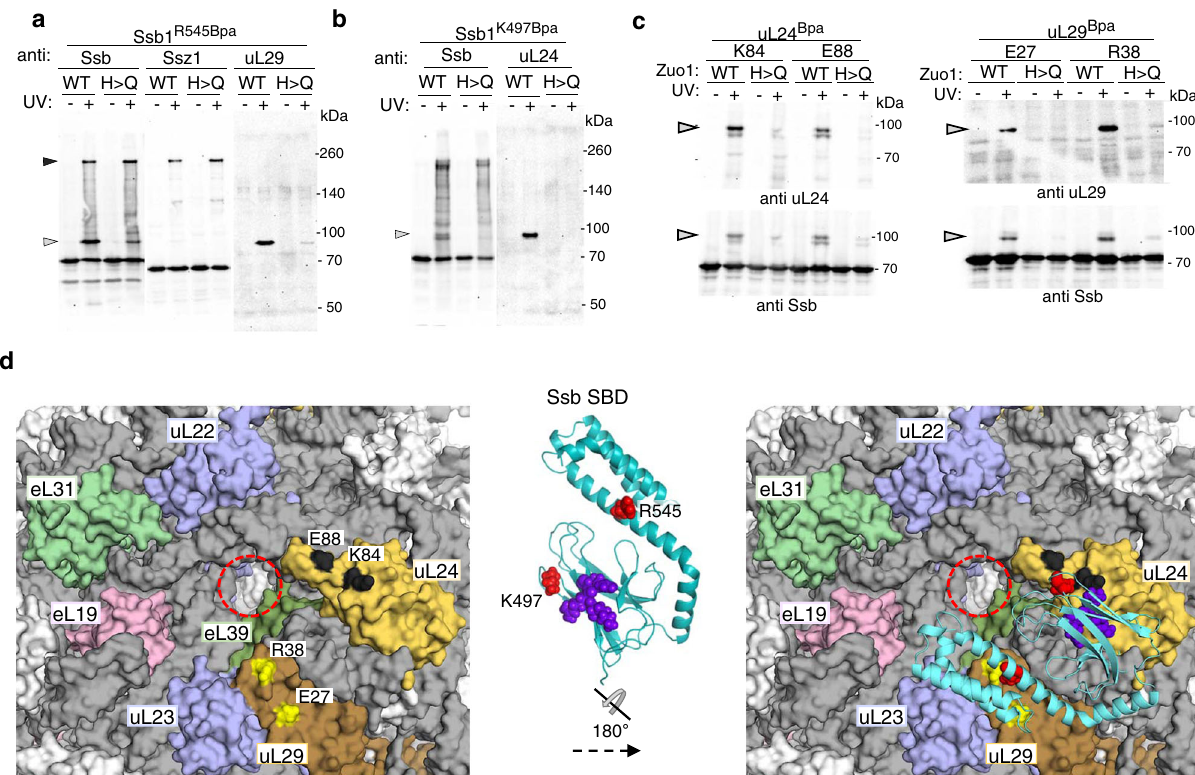
Fig. 4 Ssb cross-linking to Ssz1 and ribosomal proteins in zuo1 H128Q background. a , b ZUO1 (WT) and zuo1 H128Q (H > Q) cells expressing Ssb1 R545Bpa ( a ) or Ssb1 K497Bpa ( b ) were exposed to UV light ( + ) or, as a control, left unexposed ( − ). Cross-linking was analyzed by immunoblotting after SDS-PAGE with antibodies (anti) speci fi c for indicated proteins. Arrowheads indicate cross-link products between Ssb1 and ribosomal protein uL29 or uL24. Uncropped blots are provided as a Source Data fi le. Three independent strains were analyzed for each Bpa variant, with similar results. c ZUO1 (WT) and zuo1 H128Q (H > Q) cells expressing Bpa variants of uL24 (K84 or E88) or uL29 (E27 or R38) were exposed to UV light ( + ) or, as a control, left unexposed ( − ). Cross- linking was analyzed by immunoblotting after SDS-PAGE with antibodies (anti) speci fi c for indicated proteins. Arrowheads indicate cross-link products between uL24 or uL29 and Ssb. Uncropped blots are provided as a Source Data fi le. Three independent strains were analyzed for each Bpa variant, with similar results. d left , structure of S. cerevisiae 60 S ribosome subunit (PDB 3J78). Ribosomal proteins near the tunnel exit, which were tested in this study, are colored and labeled; ribosomal proteins not tested in dark gray; ribosomal RNA in light gray. Red dashed circle surrounds the tunnel exit. Positions of uL29 and uL24 that cross-linked to Ssb shown in yellow (R38, E27) and black (K84, E88), respectively. SBD of Ssb1(ADP), modeled using the DnaK SBD structure (PDB 2KHO), with residues (428 – 430) of 428 KRR 430 tripeptide (purple) and positions cross-linking to ribosomal proteins when Bpa incorporated (R545 and K597, red) shown in sphere representation. right , SBD fl ipped 180° and positioned on the ribosome structure in PyMOL manually according to cross-linking data shown in ( a – c